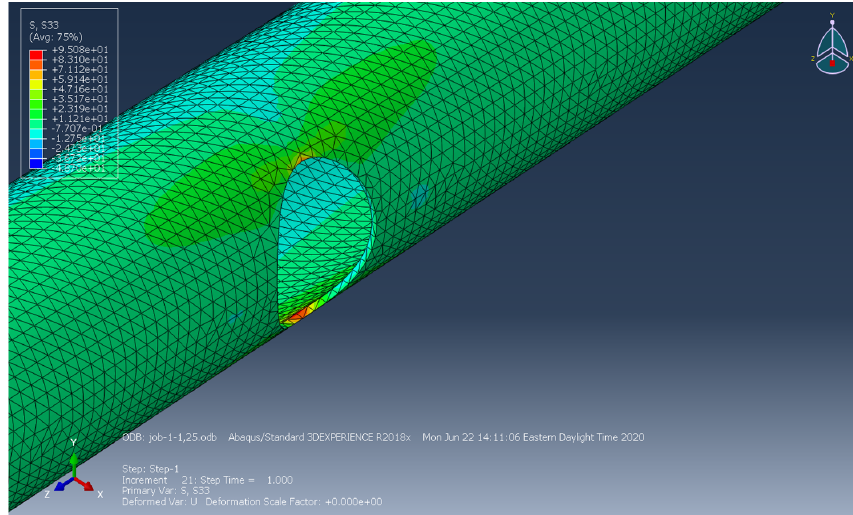
Figure 15. Aspect ratio 1-1.25 in longitudinal (Z) direction.